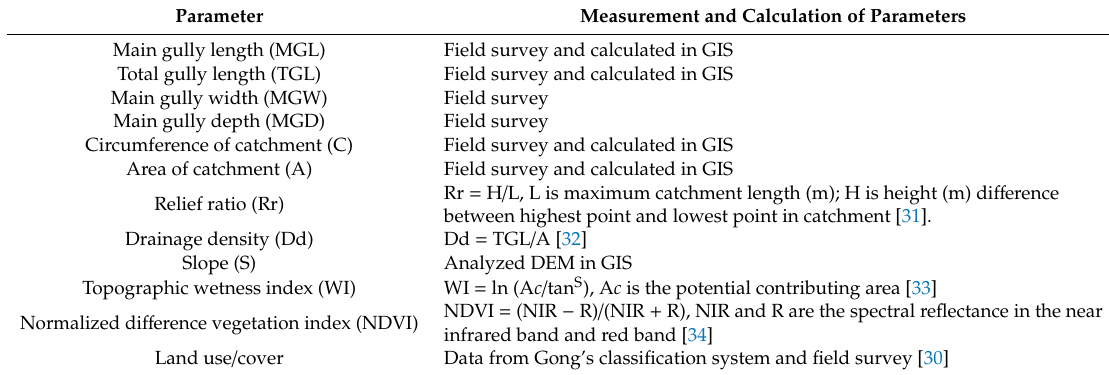
Table 1. Details characteristics of gully and